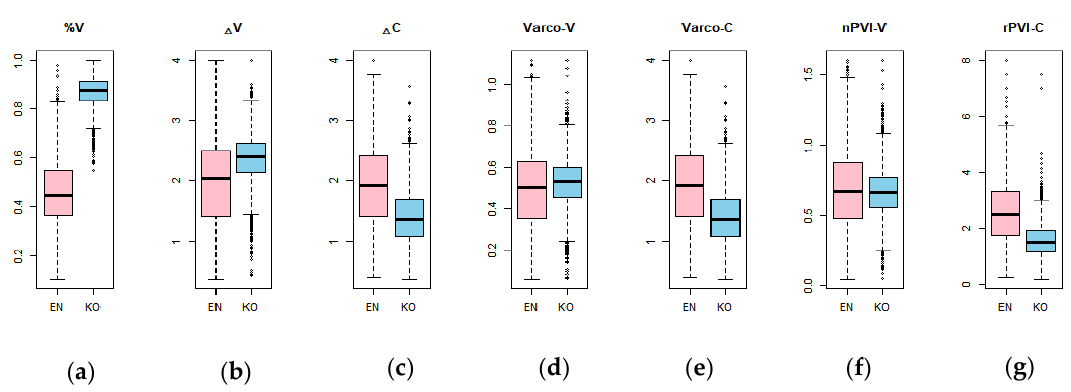
Figure 6. Tendency of distribution of rhythm metric values for English and Korean.